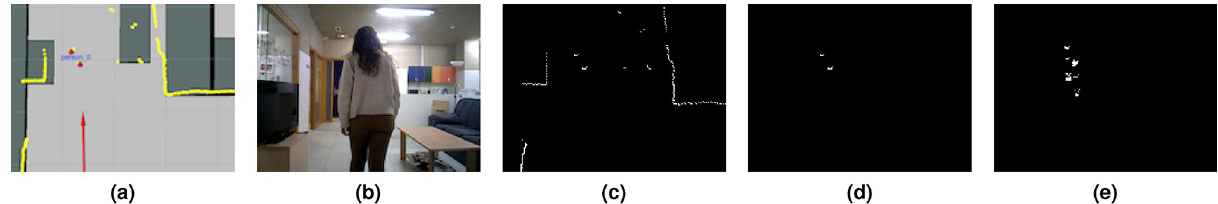
Figure 2. Data curation process: ( a ) Laser Imaging Detection and Ranging (LIDAR) and People Tracking (PeTra) data visualized on Rviz—The red arrow shows the robot’s location an orientation, the yellow points show Laser Imaging Detection and Ranging (LIDAR) readings; ( b ) snapshot from Orbi-One robot camera; ( c ) occupancy map computed from Laser Imaging Detection and Ranging (LIDAR) data; ( d ) occupancy map computed by People Tracking (PeTra); and ( e ) occupancy map aggregation.